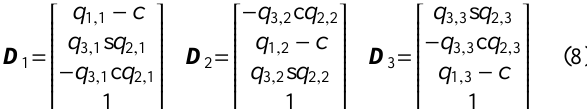
Figure 2. Reference frames along leg